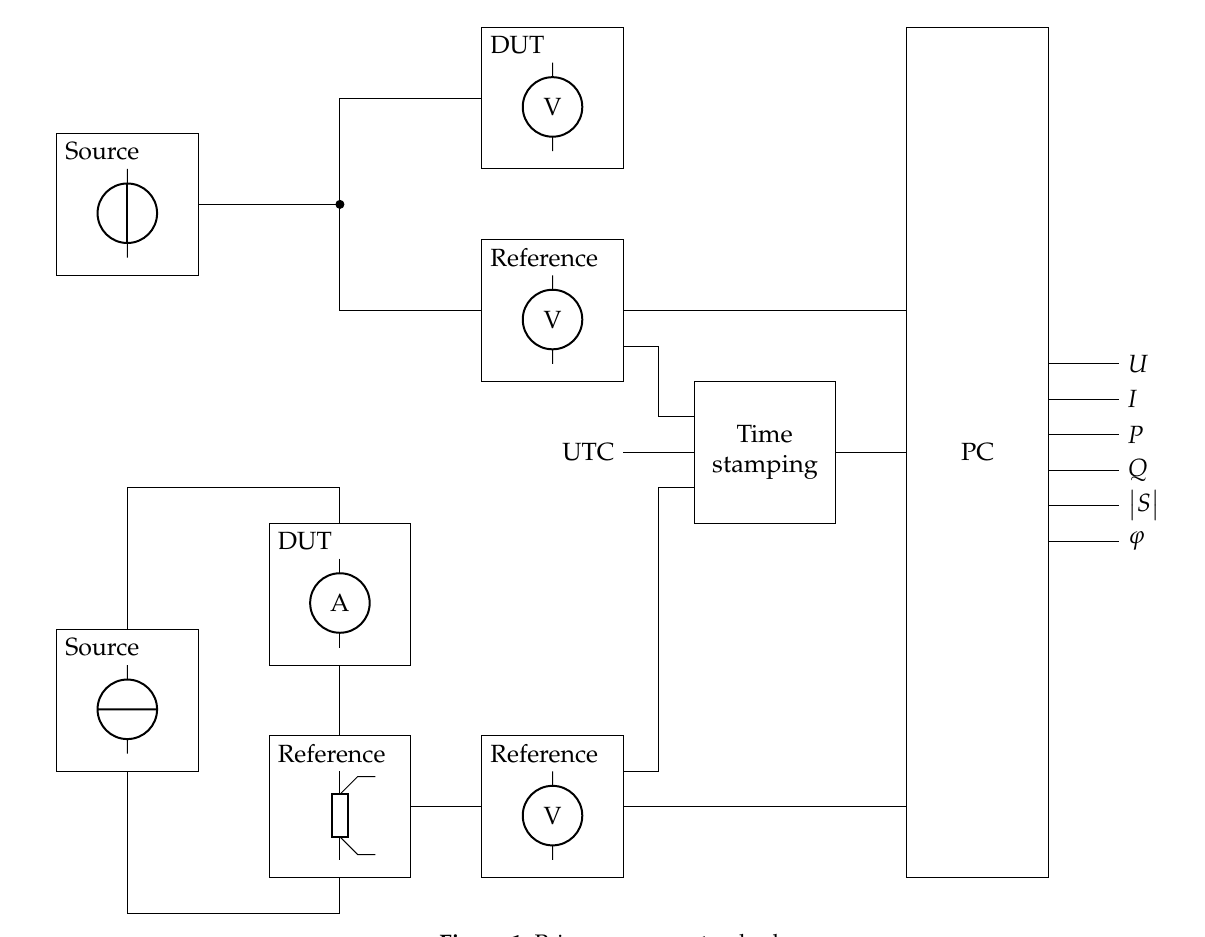
Figure 1. Primary power standard. Table 1. Uncertainty of shunt AC resistance.